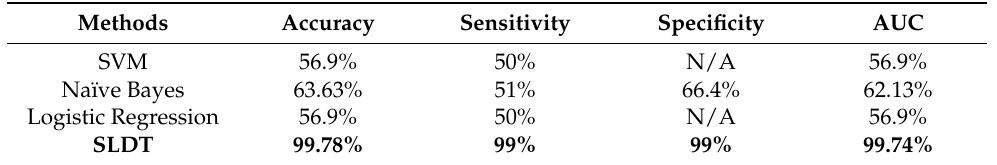
Table 5. Performance measures of the proposed method with other machine learning methods by the CHN dataset.